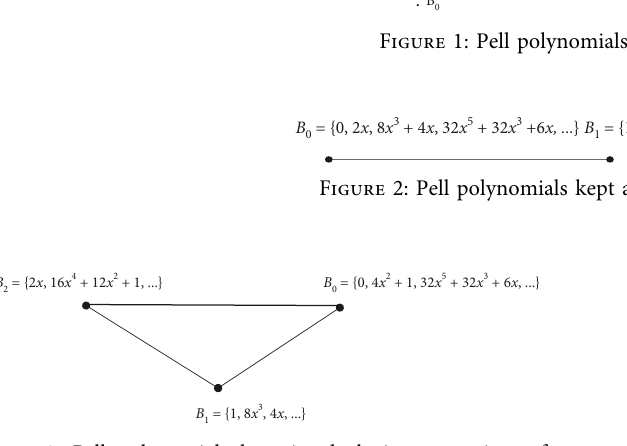
Figure 3: Pell polynomials kept in clockwise to vertices of a triangle.